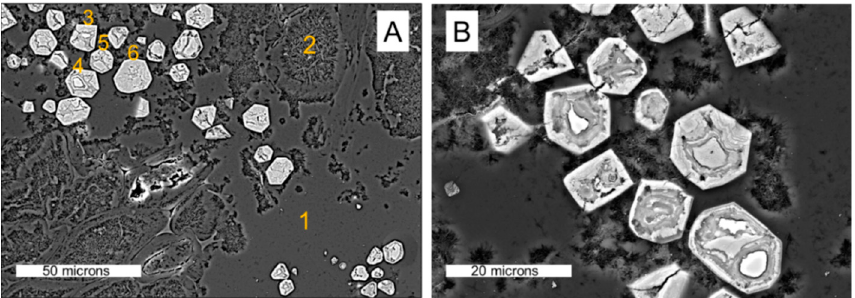
Figure 11. Elemental analyses of opalized wood. ( A ) Positions of the analyses (1–6) shown in Table 1; ( B ) detailed SEM BSE image of iron-rich microcrystals. Table 1. Elemental analysis by EDS of Clover Creek opalized wood, the part with iron-rich microcrystals. Element Percent Location